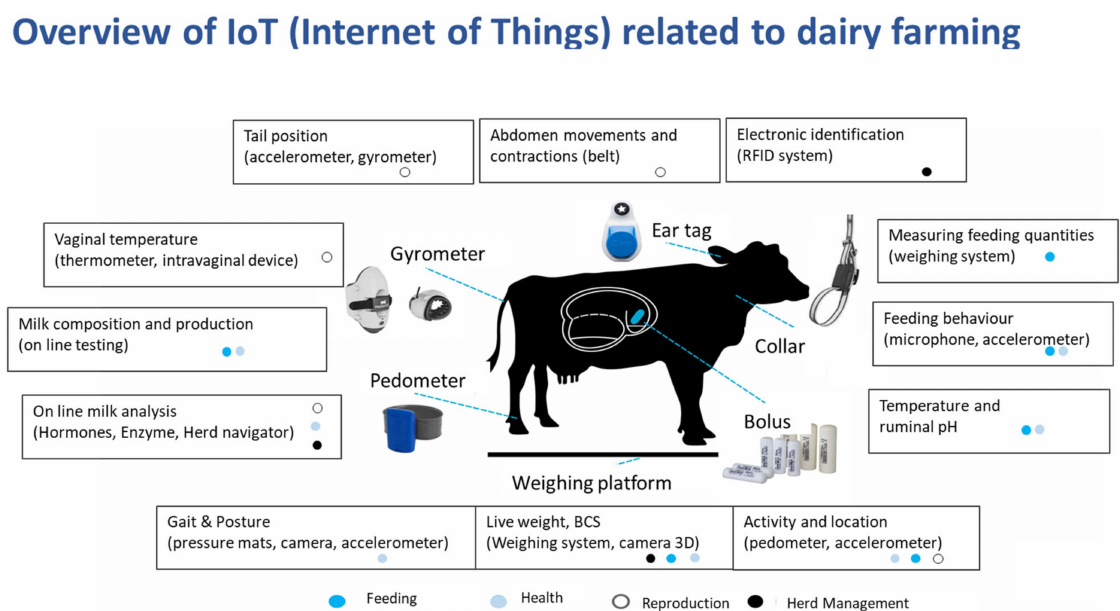
Figure 2. Overview of currently used devices to capture biological data from animals. All these sensors are connected and can hence be understood as the application of the “Internet of Things” to the dairy cattle sector.